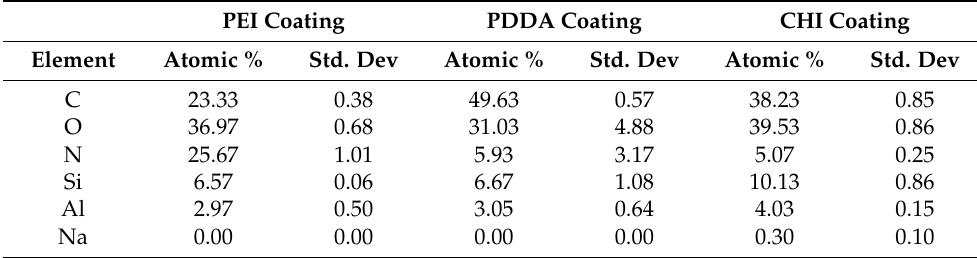
Table 5. EDX analysis conducted on glass slides deposited with 60 QL